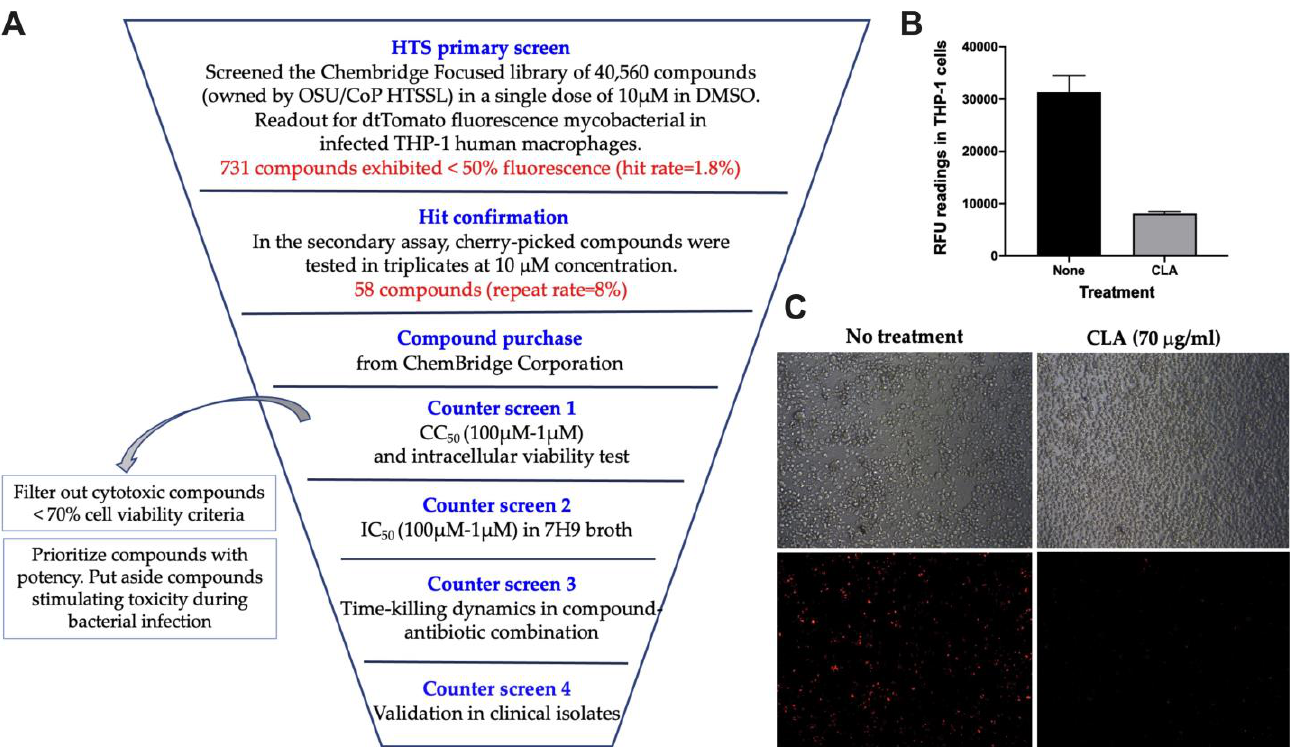
Figure 1. The development of the fluorescent-based HTS assay for identification of compounds with potency in infected macrophages. ( A ) The HTS screen triage. ( B ) Red fluorescence units (RFU) of MAH-T-infected THP-1 macrophages with and without antibiotic treatment at day 7. ( C ) Phase contrast and fluorescent images of MAH-T-infected THP-1 cells with MOI of 40:1 on day 7